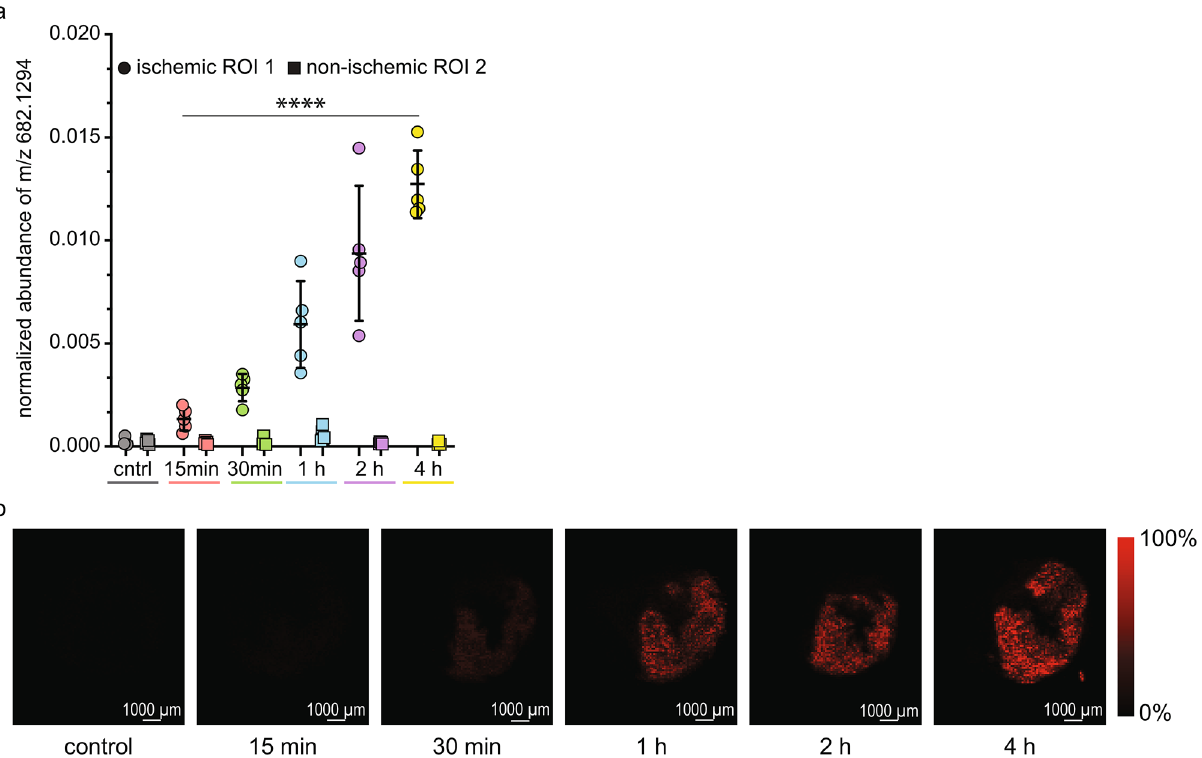
Figure 5. Possibly S-NADHX (m/z 682.1294) is nearly absent in the non-ischemic control but is significantly upregulated starting 15 min in the predicted ischemic area. ( a ) Temporal expression of possibly S-NADHX in ischemic (ROI 1, represented by circles) and non-ischemic (ROI 2, represented by squares) regions; n = 5 per time point (biological replicates); statistical significance was determined by multivariate regression analysis using Benjamini-Hochberg’s FDR (****P < 0.0005). ( b ) Image reconstruction of possibly S-NADHX in selected samples at the different time points; n = 5 per time point; abundance is represented by colour: black and red corresponding to low and high abundance, respectively.